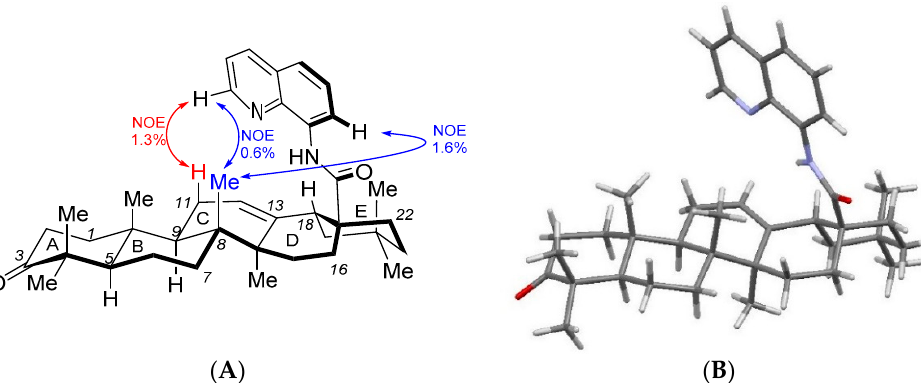
Figure 1. Comparison of NOE effects observed in solution ( A ) and molecular structure obtained by single-crystal X-ray analysis ( B ) of compound 3a .